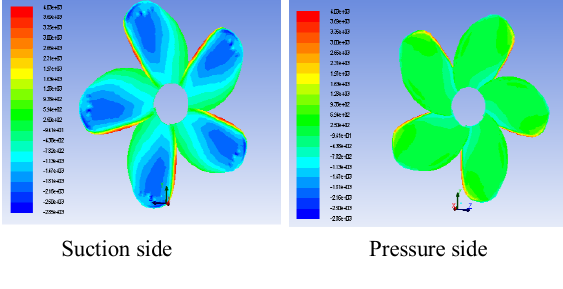
Pressure side Suction side